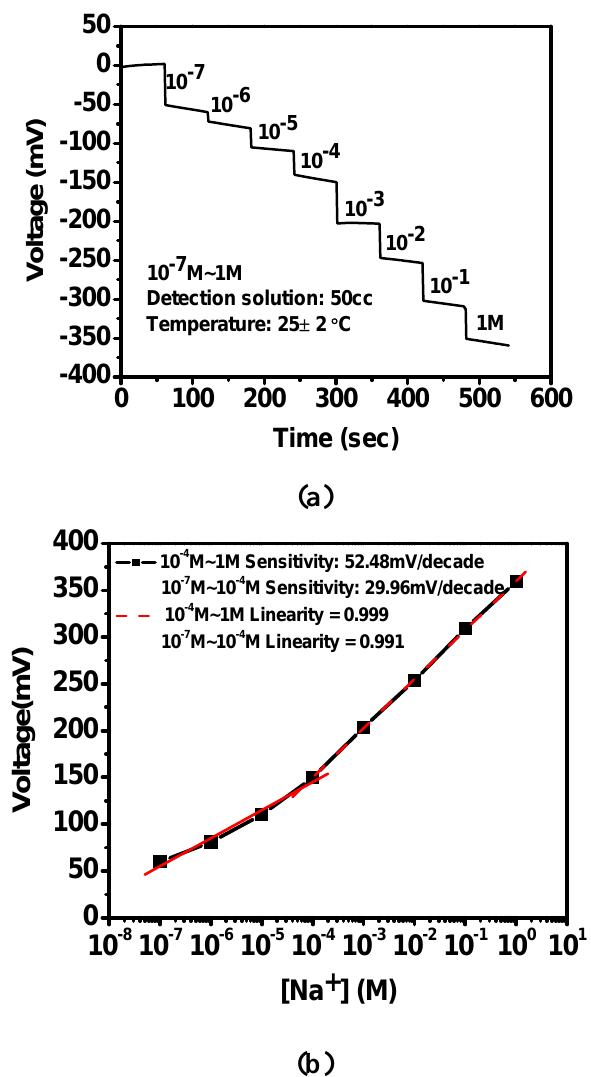
Figure 8. Sodium ion selective electrode based on anodized-ITO for (a) output response voltage vs . times with titration and (b) corresponding